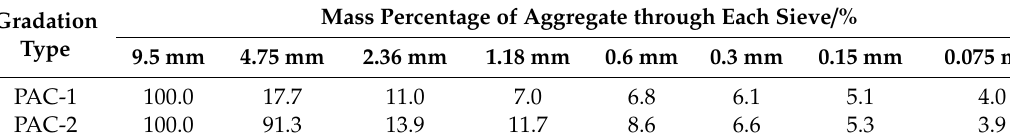
Table 5. Gradation of two porous asphalt concretes (PACs).